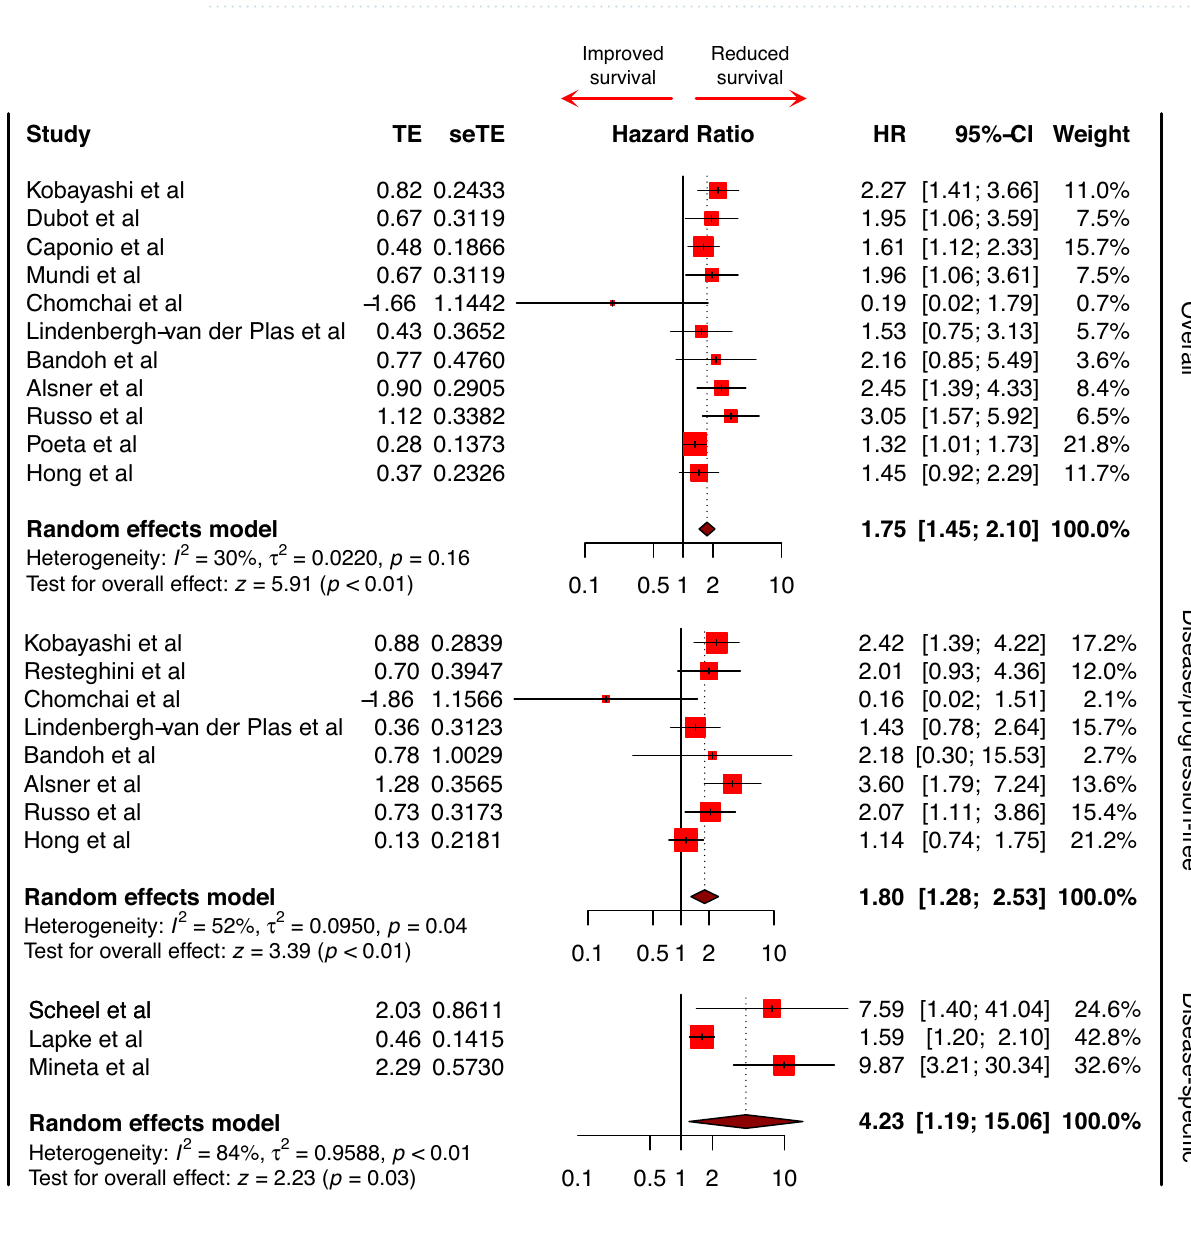
Table 2. Summary table of key outcomes from each study.